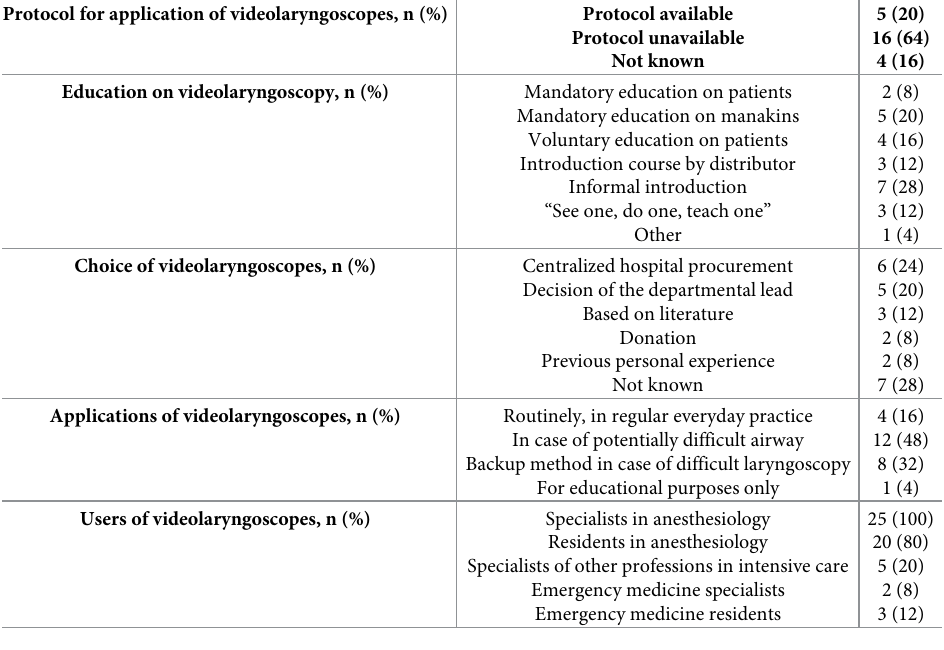
Data are reported as raw numbers (n) and percentages (%).